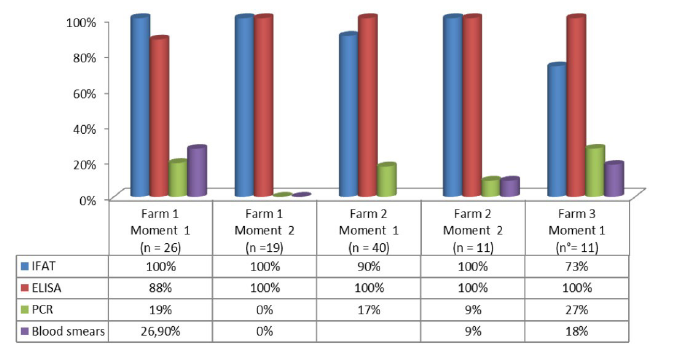
Figure 3. Parasitological, serological, and molecular diagnosis of trypanosomiasis in three dairy farms. Farm 1-Municipality of BomConselho/PE. Farm 2 - Municipality of Pedra/PE. Farm 3- Municipality of